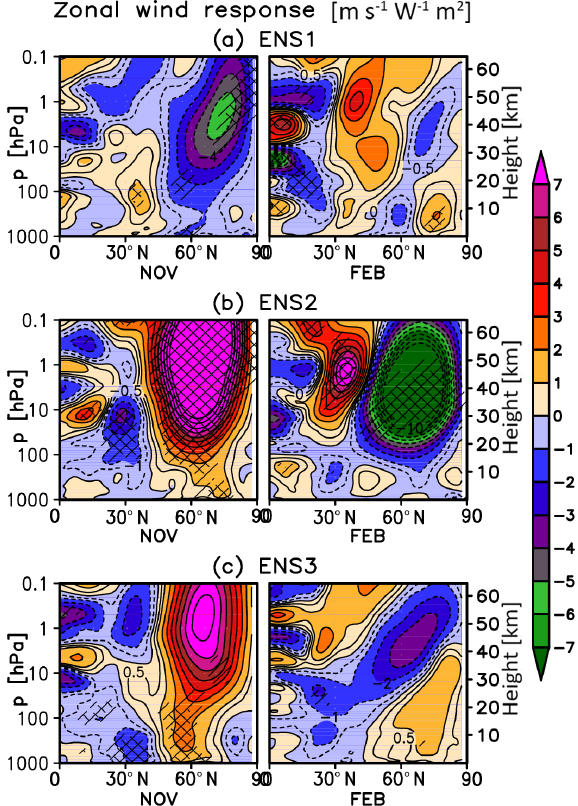
Figure 12. Monthly mean November (left) and February (right) zonal mean zonal wind response (ms − 1 W − 1 m 2 ) in UM-UKCA derived using MLR for the individual ensemble members (ENS1- 3). Single and double hatching indicates statistical significance on the 90% and 95% level ( t test). Note the additional contours at ± 0 . 5, ± 8, ± 9 and ± 10ms − 1 W − 1 m 2 . See Fig. S5 for all months from November to